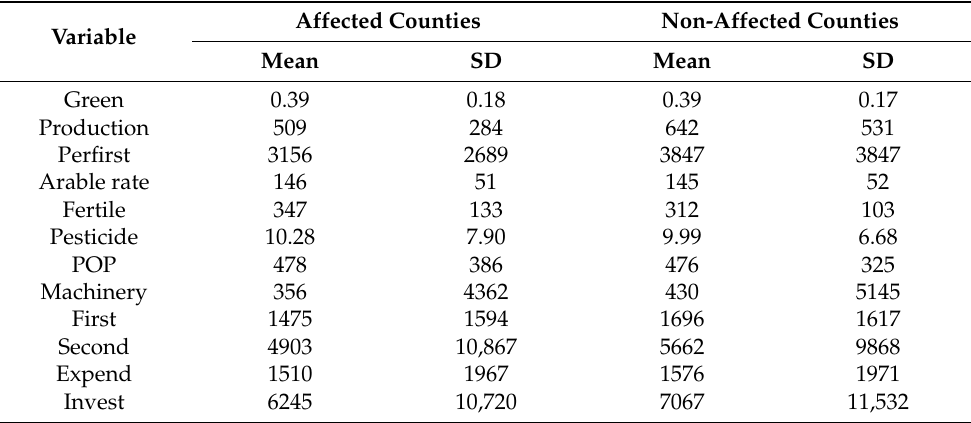
Table 3. Descriptive statistics for the main